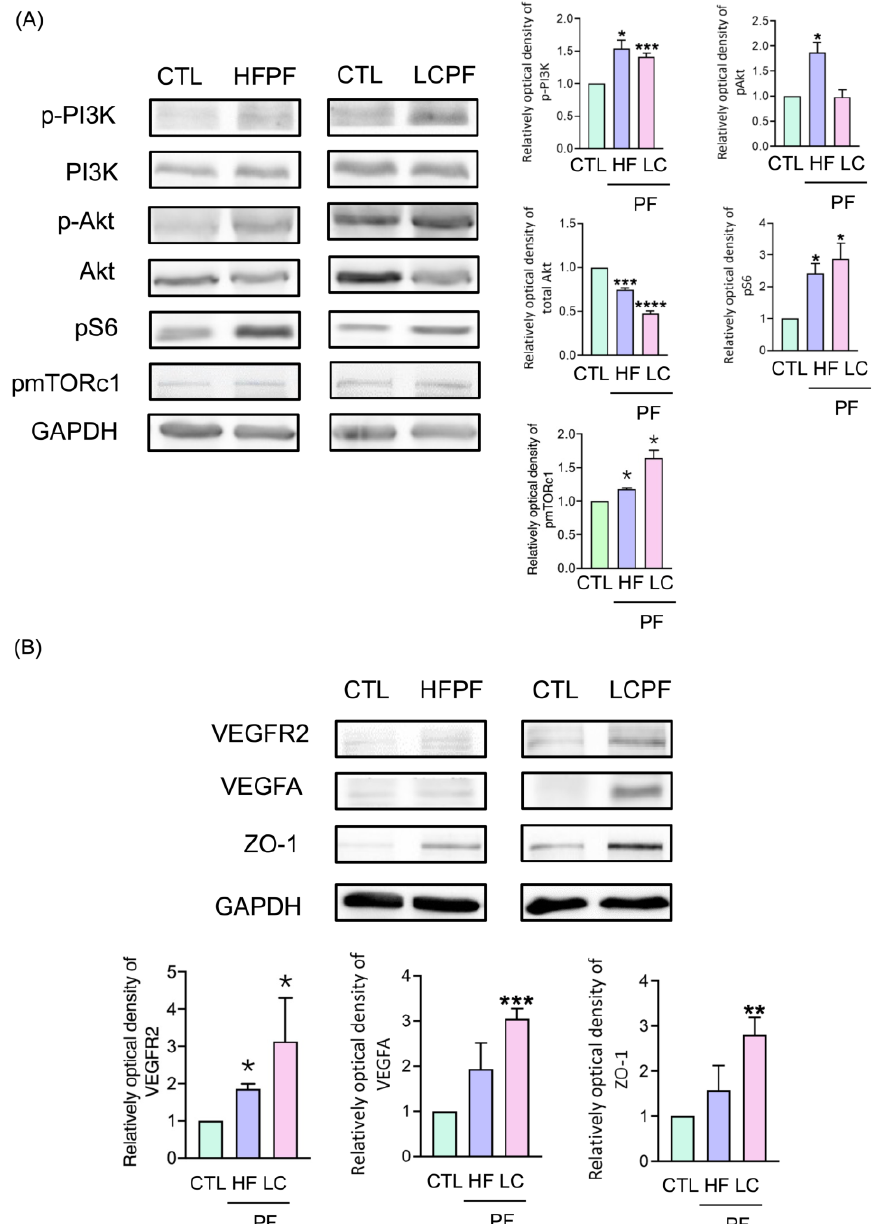
Figure 4. Upregulated PI3K/Akt and angiogenesis signaling via HFPF and LCPF in HaCaT cells. HaCaT cells were individually treated with HFPF, LCPF, or control medium for 24 h. ( A ) p -PI3K, p -Akt, pS6, and PPAR γ , and ( B ) VEGFR2, VEGFA, and Zonula occludens-1 protein expression was examined via Western blot analysis. GAPDH was used as an internal control. * p < 0.05; ** p < 0.01; *** p < 0.005; **** p < 0.0001 compared to the control group.